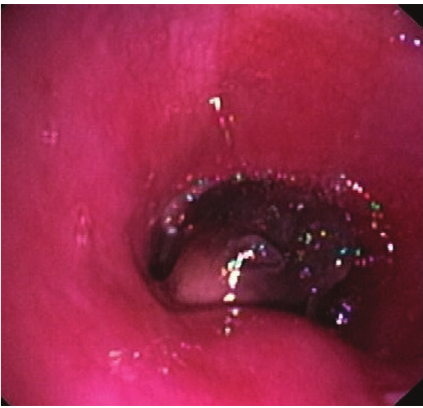
Figure 3: The bronchoscopic image revealed the extensive intralu- minal growth of the